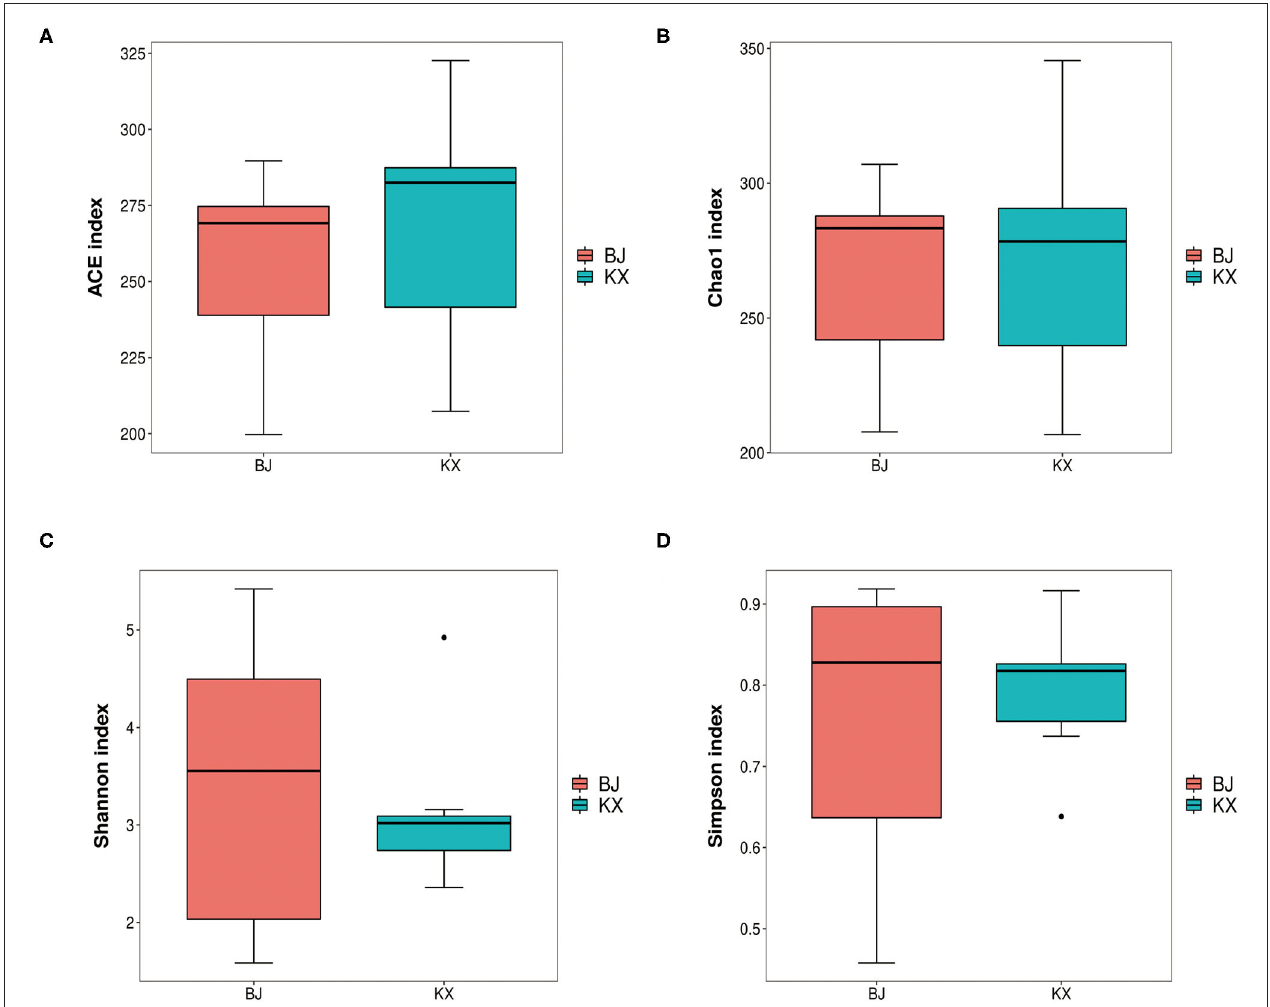
FIGURE 3 | Abundance-based coverage estimator (ACE) index (A) , Chao1 diversity (B) , Shannon diversity (C) , and Simpson indices (D) of bacterial populations in each sample. BJ, Bojiang Haizi; KX, Mu Us